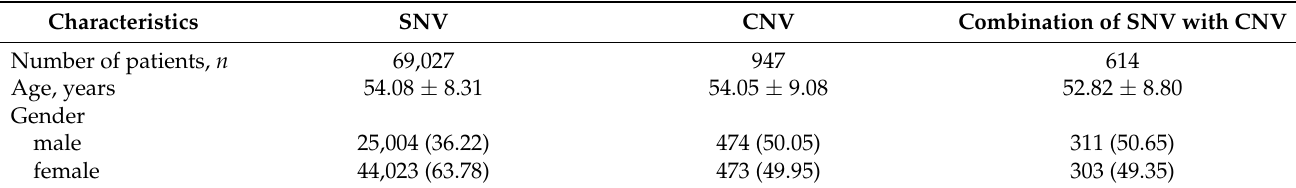
Table 1. Demographic characteristics of study